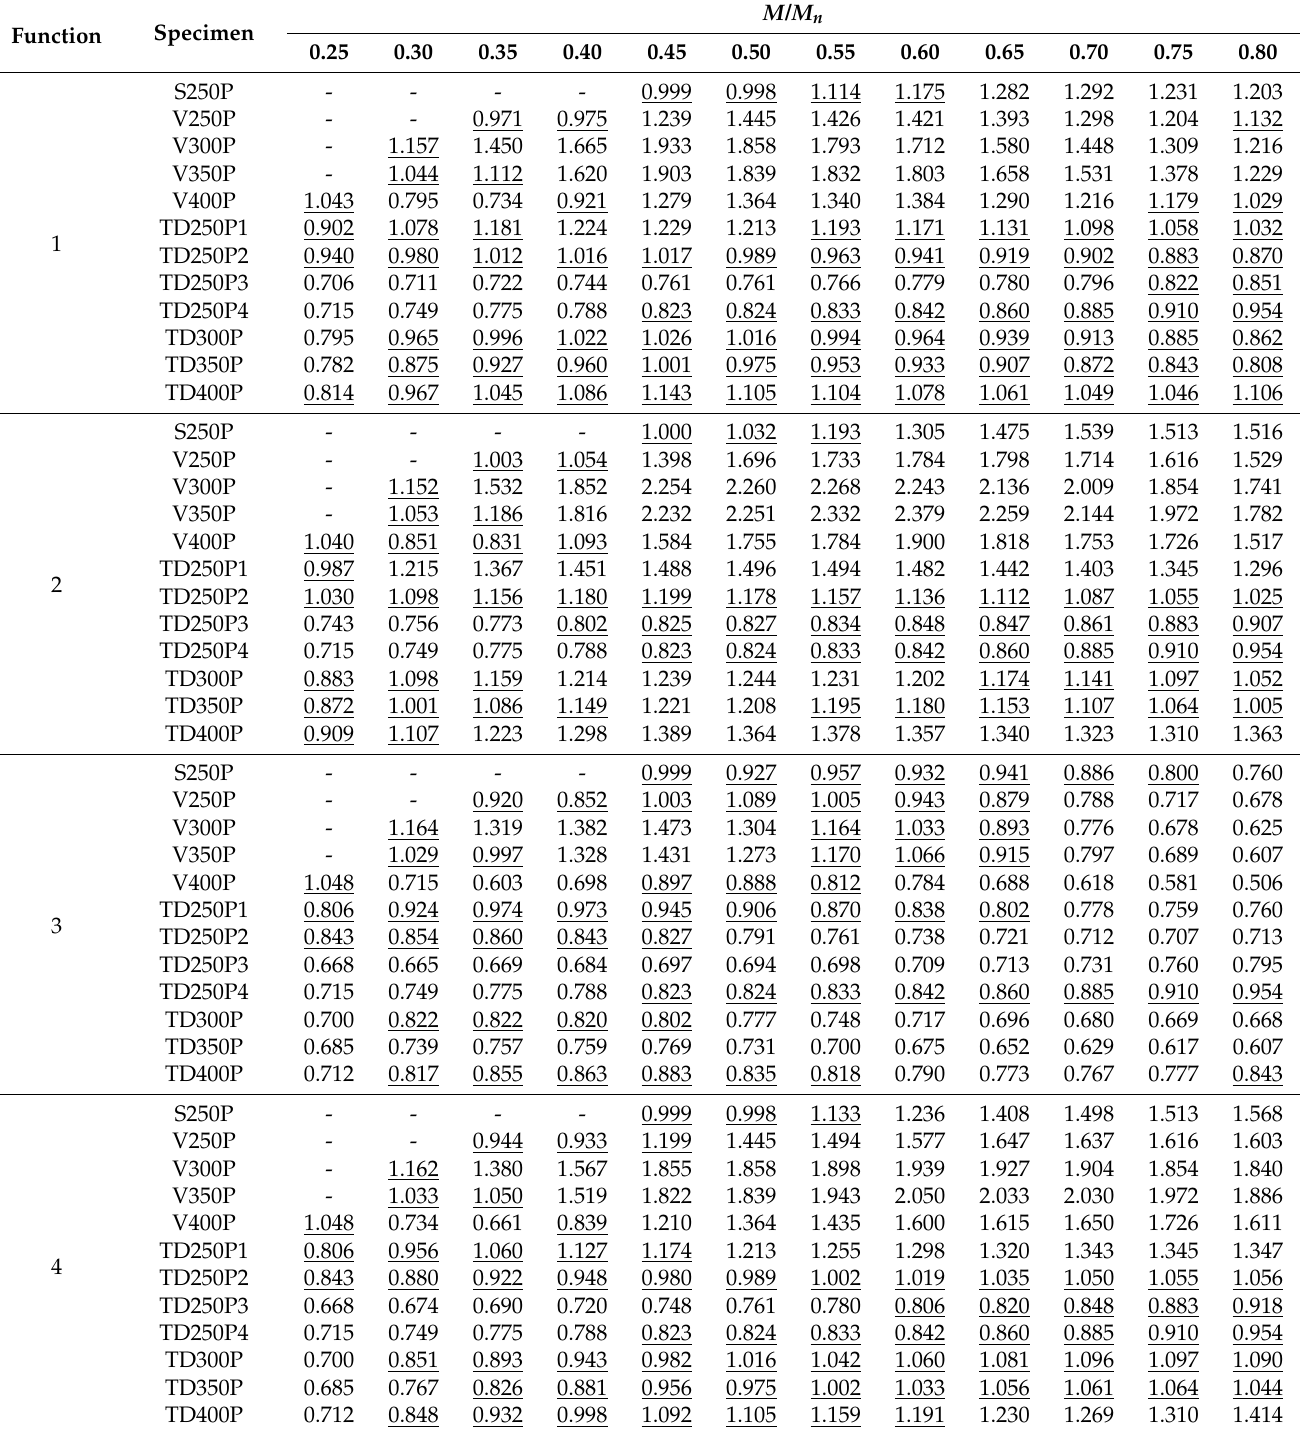
Table 9. Comparison of immediate deflection ( δ exp / δ cal